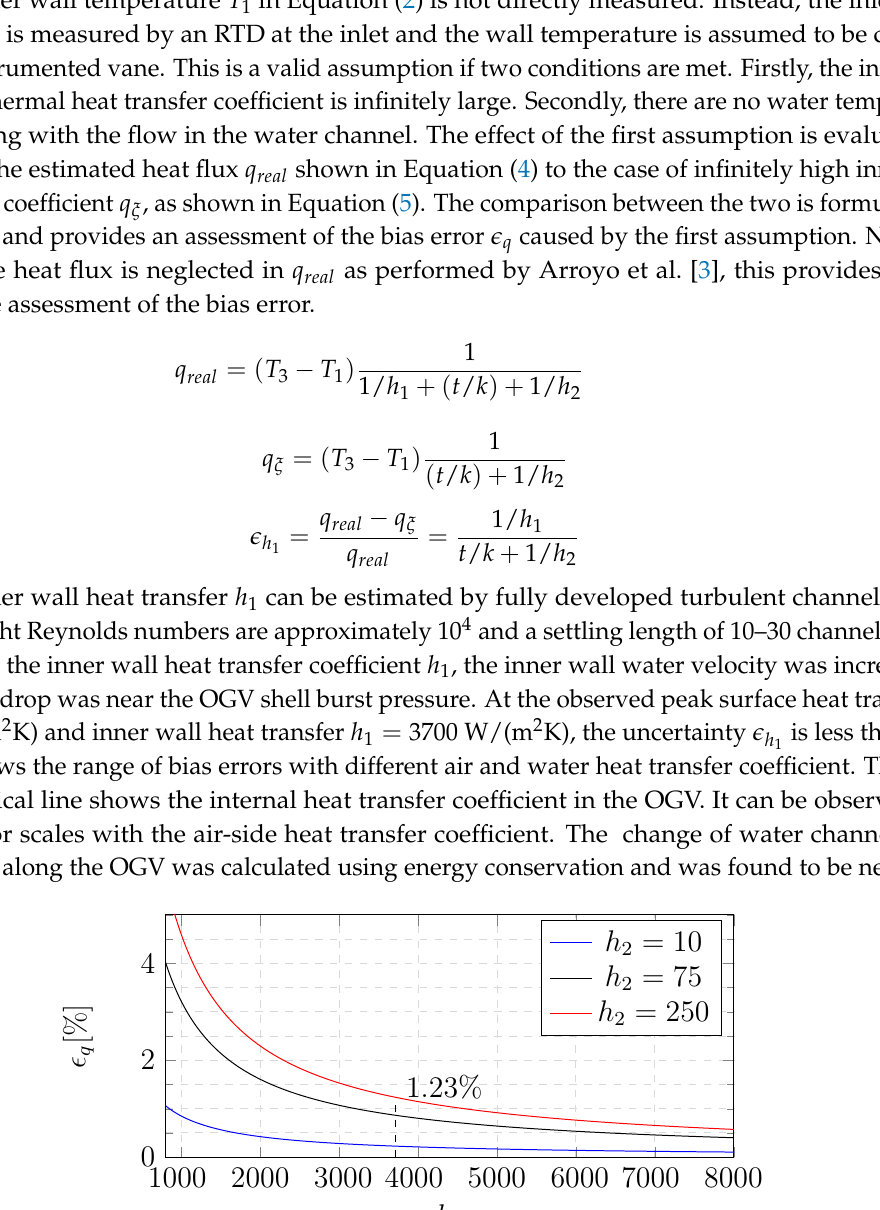
for different h 2 and h 1 , vertical line shows h 1 in 1